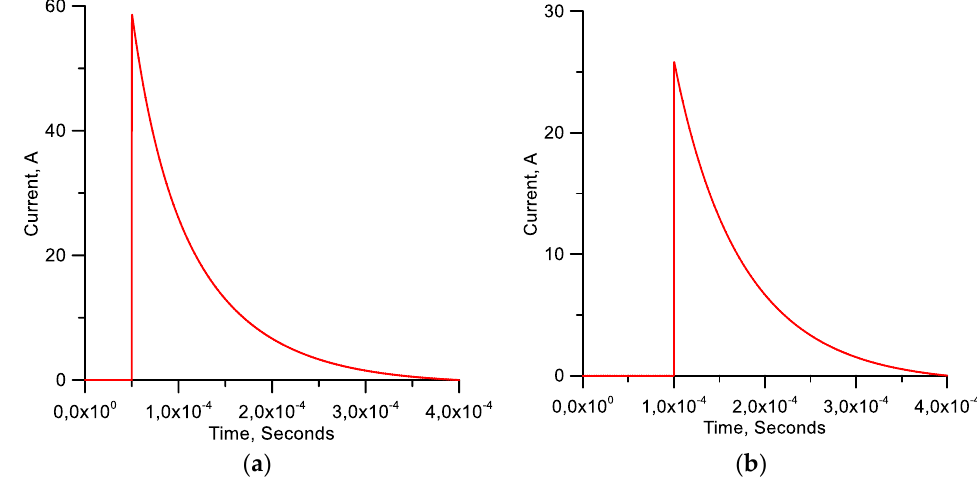
Figure 4. The mini-return stroke current at a height of ( a ) 5 km and ( b ) 10 km.